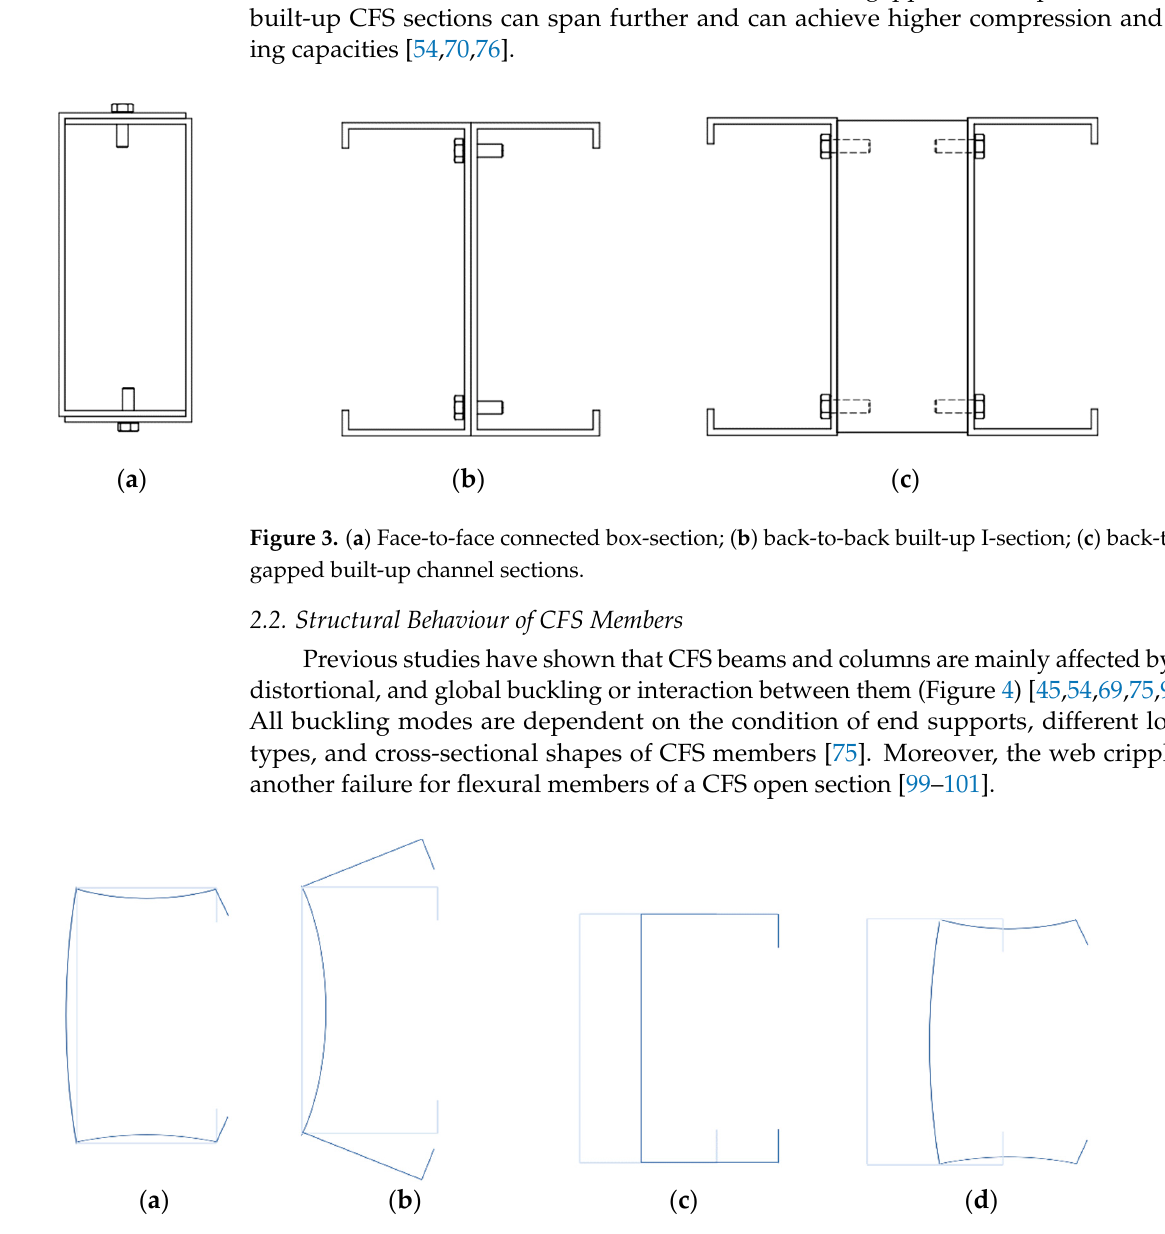
Figure 4. The buckling modes of CFS lipped channel sections with conditions of ( a ) local, ( b ) distortional, ( c ) global, and ( d ) local-flexural interactive buckling.